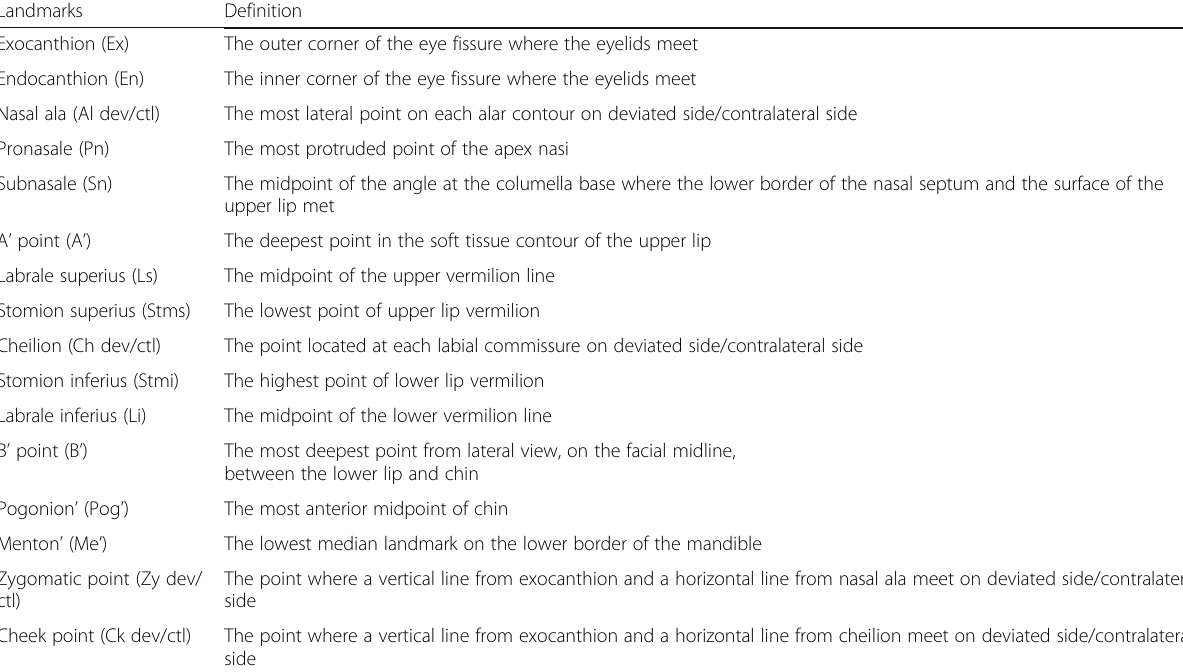
Table 2 Description of 3D soft tissue landmarks in the study